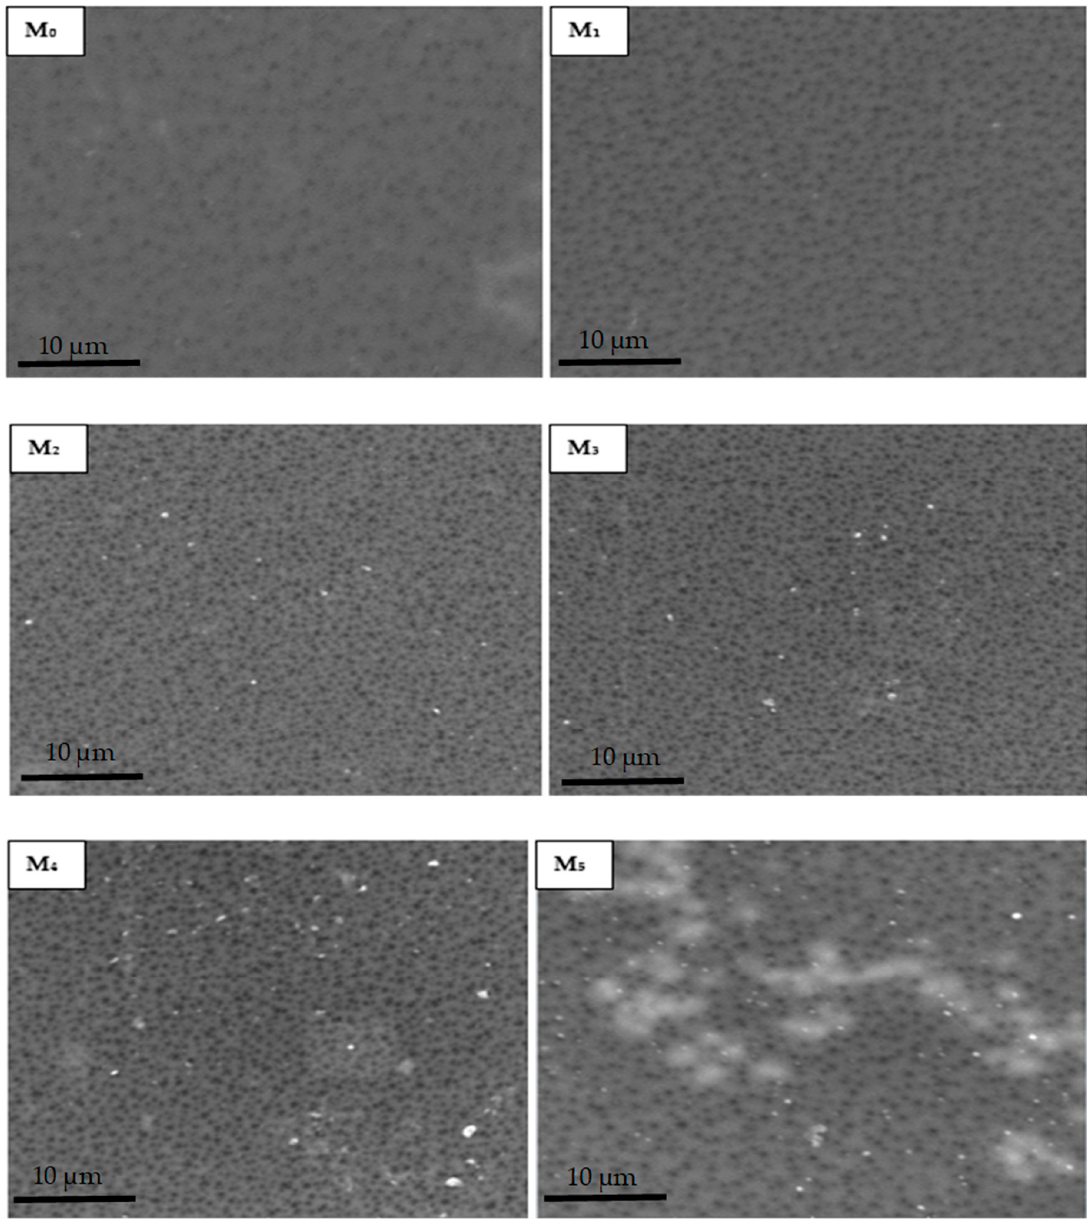
Figure 4. SEM micrographs of membranes with varying amounts of PSN: (M 0 ) 0.00 wt %, (M 1 ) 0.05 wt %, (M 2 ) 0.10 wt %, (M 3 ) 0.30 wt %, (M 4 ) 0.50 wt %, and (M 5 ) 1.00 wt %.